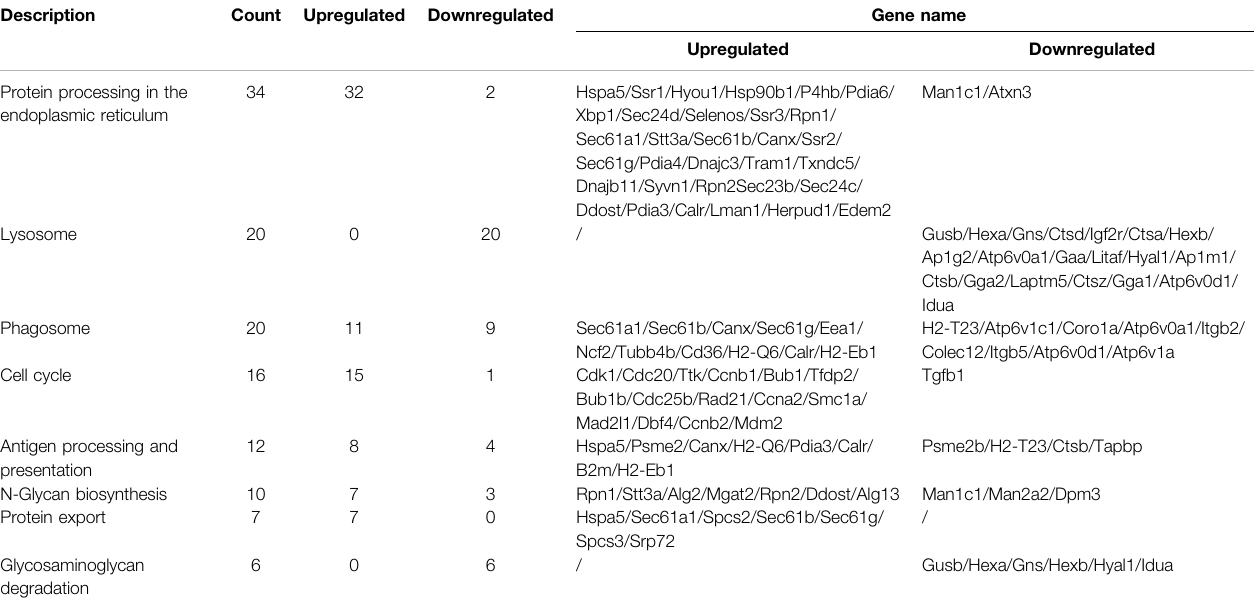
TABLE 3 | Upregulated and downregulated DEGs in the top eight most signi fi cant results of KEGG enrichment. Description Count Upregulated